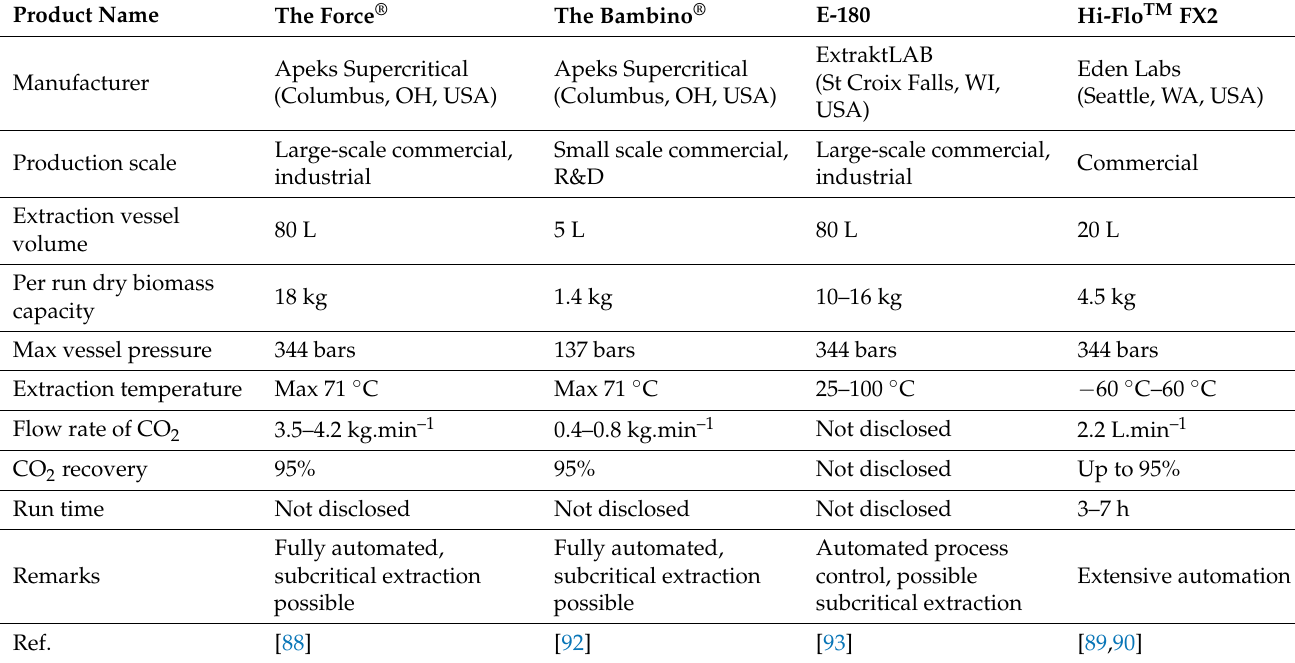
Table 4. Different SC-CO 2 extraction pieces of equipment used in cannabinoid extraction and their technical details. Adapted from Terasvalli H. [91], reprint permission had been obtained from the LUT university (Copyright 2020).